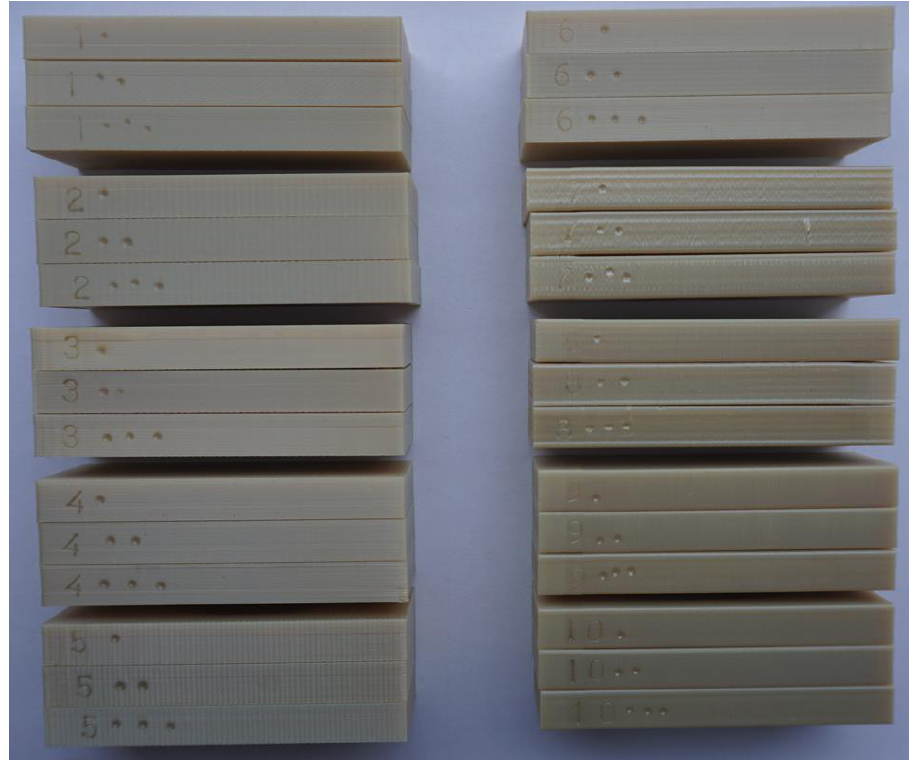
Figure 5. The series of samples used in the experiment.